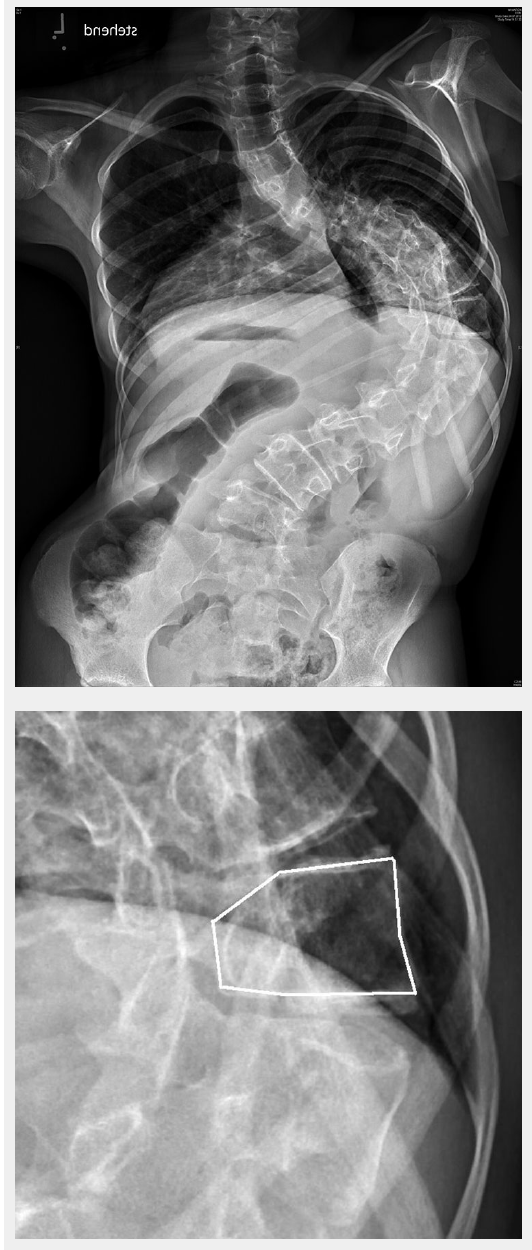
Figure 1 A 12-year old otherwise healthy girl with an idiopathic adolescent scoliosis: 130° right convex thoracic curve wit elevation of the right shoulder and pelvic asymmetry. The patient and her family seeked a doctor’s advice because of a prominent right thorax (rib hump) and a flattened right waist line. Pain was not an issue, nor was there any neurological compromise. B High loads on a growth plate leads to diminuition of growth and vice versa [25]. A typical example is the wedge shaped apical vertebra in a scoliotic curve due to high load on the concave (inner) side of the curve.